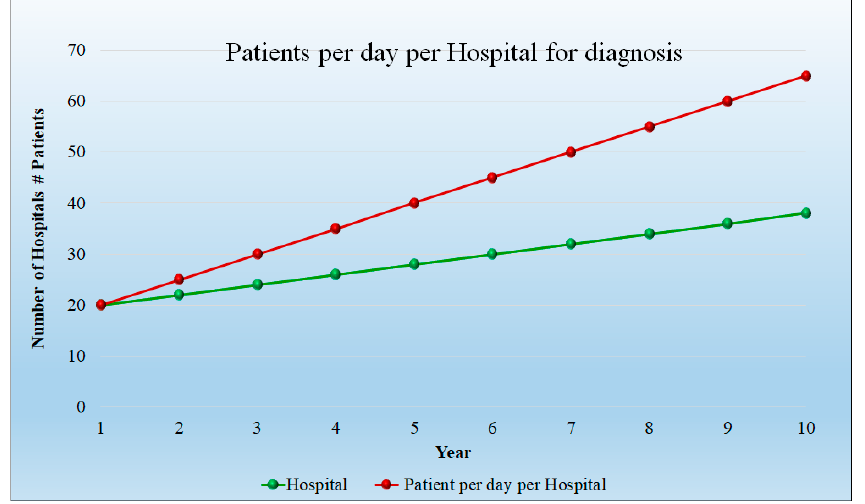
Figure 10. Patients per day per hospital for diagnosis.